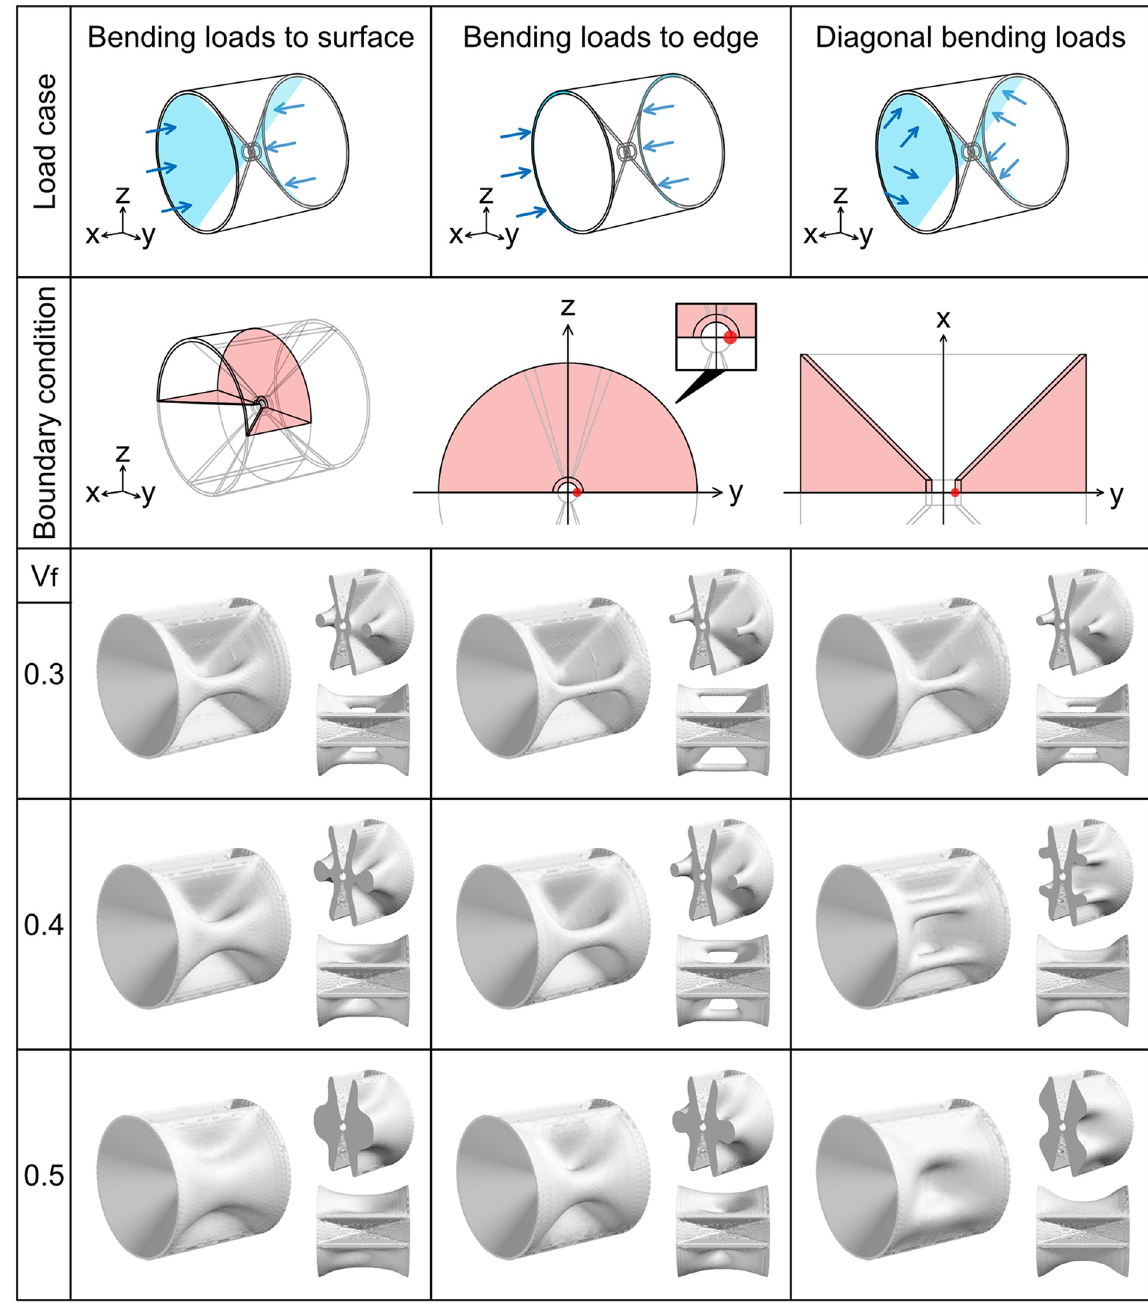
Fig 4. Optimization for bending loads to autocentrum. The arrangement and color scheme of the images are the same as those described in Fig 3. The boundary condition is the same in the three different bending load cases. We imposed the symmetric boundary condition u � n = 0 on the xy and yz planes (left image in the second row from the top) and used a quarter model. The middle and right images in the second row from the top are the areas to which the symmetric boundary condition was imposed on the yz and xy plane, respectively. The magnified image of the center on the yz plane is shown. We imposed the displacement constraint u = 0 to the point (0, C R , 0) (red dot) when the bending loads y were applied to half of the concave surface of the hourglass-shaped domain in y � 0 (the blue-colored area). When we applied the t ¼ (cid:0) F x j x j bending loads to half of the area in y � 0, we imposed the same displacement constraint to the point (0, − C R , 0). In optimization for the diagonal bending loads, the results are displayed for w = 0.8.